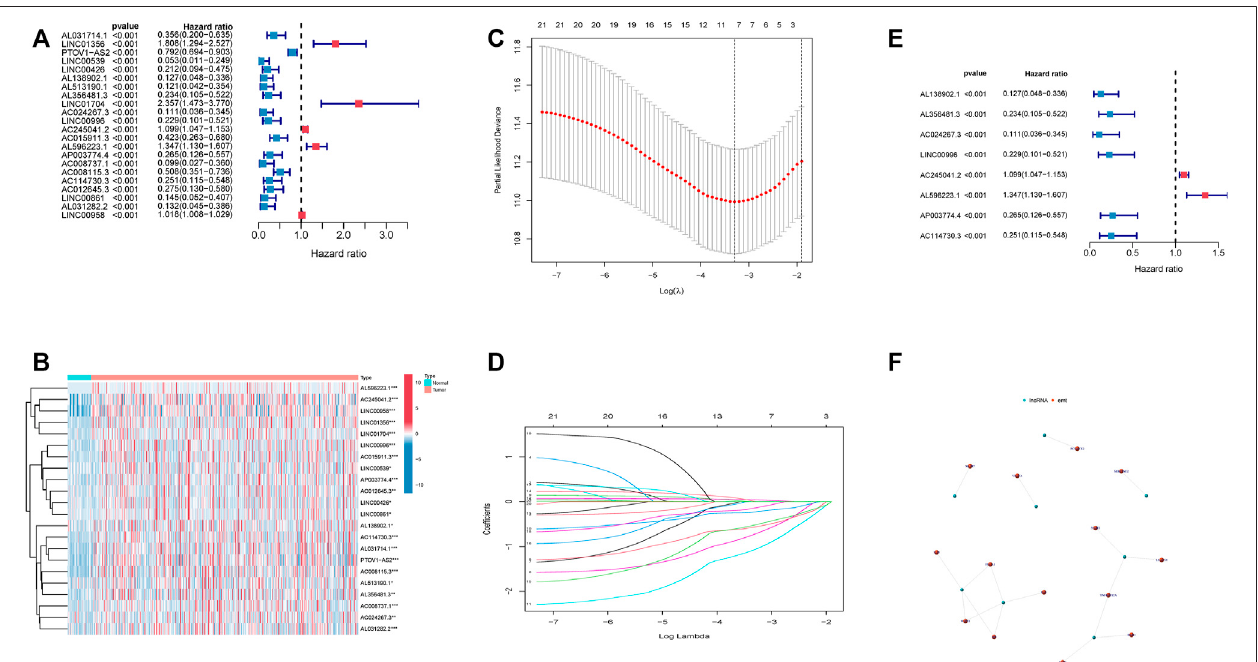
FIGURE 2 | Identi fi cation of an 8 EMT-related lncRNA prognostic signature. (A) . Univariate Cox regression analysis of 22 EMT-related lncRNAs. (B) . Heatmap of 22EMT-relatedlncRNAs. (C) .Partiallikelihooddeviancewasplottedversuslog( λ ). (D) .LASSOcoef fi cientpro fi lesoflncRNAsassociatedwithoverallsurvivalofHNSCC. (E) .Forestplotdepictingassociationsbetween8lncRNAsthatwerescreenedbyLASSOregressionanalysisandriskvalue. (F) .networkof8lncRNAandrelatedgenes.